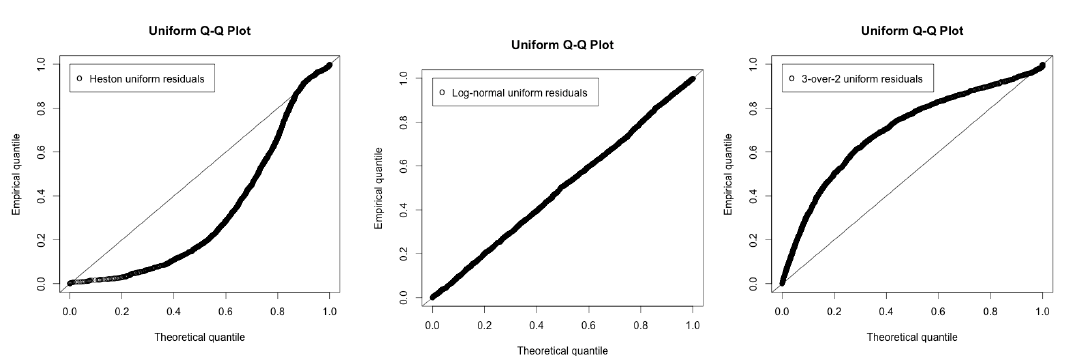
Figure 4. Quantile plots of the uniform [ 0,1 ] distribution from uniform residuals calculated with measured S&P 500 variance.